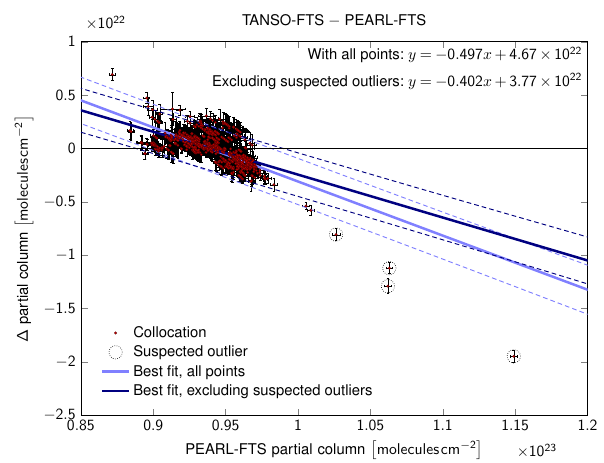
Figure 17. As in Fig. 16, but showing TANSO-FTS – PEARL-FTS in the range of 5.3–9.7km. The two regression lines correspond to a regression with either all points (light blue), or with suspected outliers excluded from the linear regression (dark blue) as described in the text.